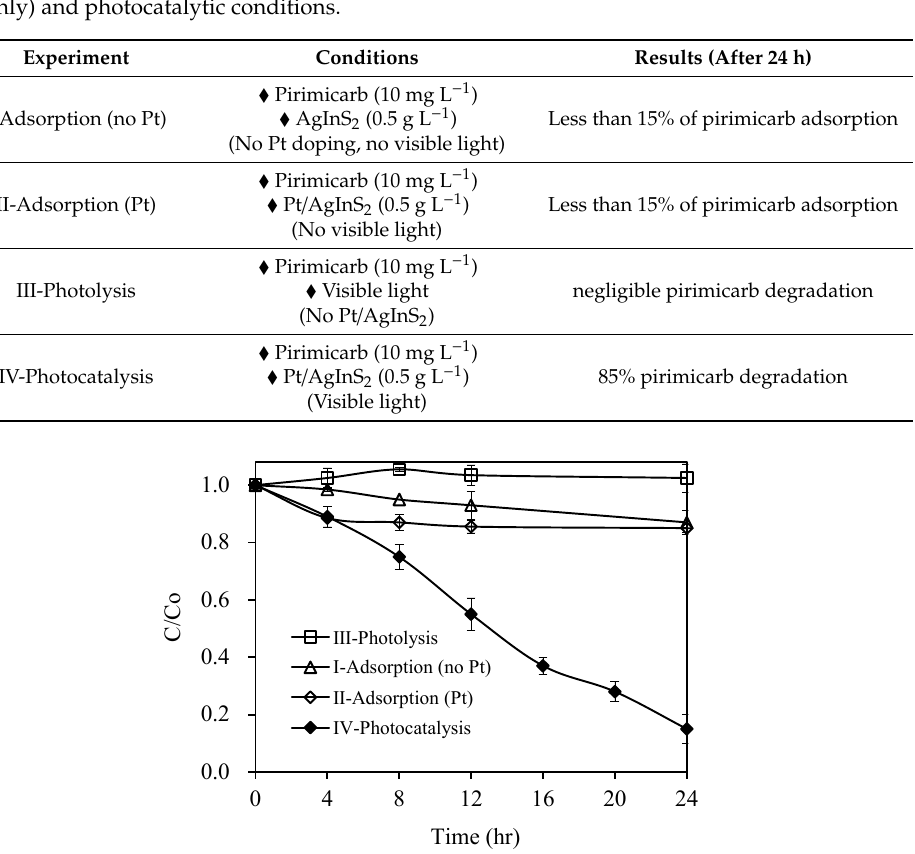
Table 2. Comparison of pirimicarb degradation between control conditions (catalyst only and visible light only) and photocatalytic conditions.